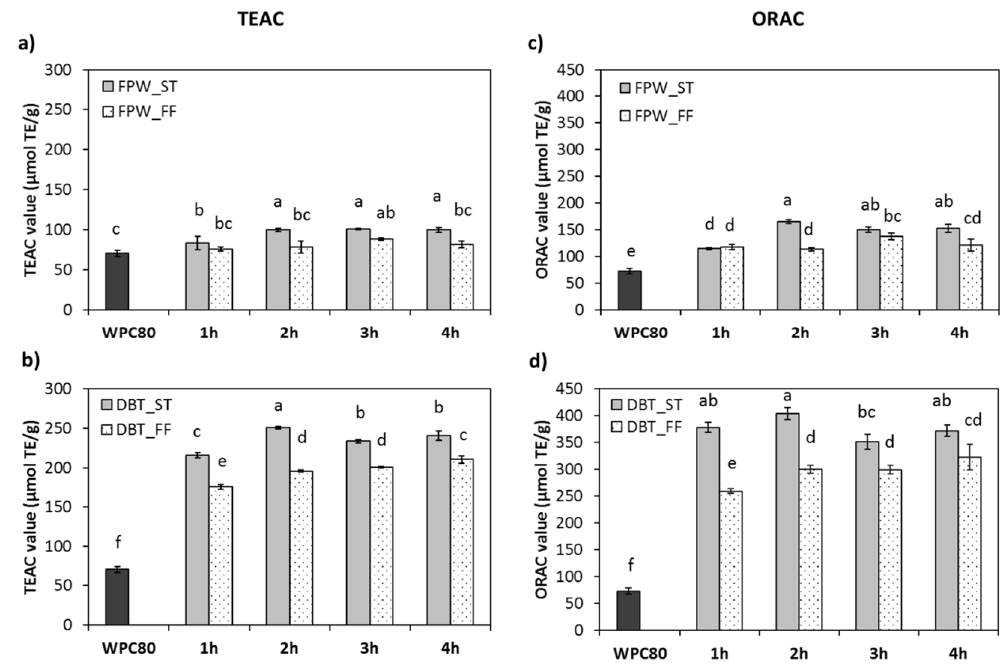
Figure 5. In vitro antioxidant activities reported as Trolox equivalent antioxidant capacity (TEAC) and oxygen radical absorbance capacity (ORAC) of unhydrolysed whey protein concentrate (WPC80) and the whey protein hydrolysates (WPHs) generated using ( a ) and ( c ) FlavorPro Whey under pH- and non pH-controlled (FPW_ST and FPW_FF, respectively) and ( b ) and ( d ) Debitrase under pH- and non pH-controlled (DBT_ST and DBT_FF, respectively) conditions during the course of 4 h hydrolysis period. Values reported are mean ± SD, n = 3. Different letters indicated significant difference at p < 0.05.